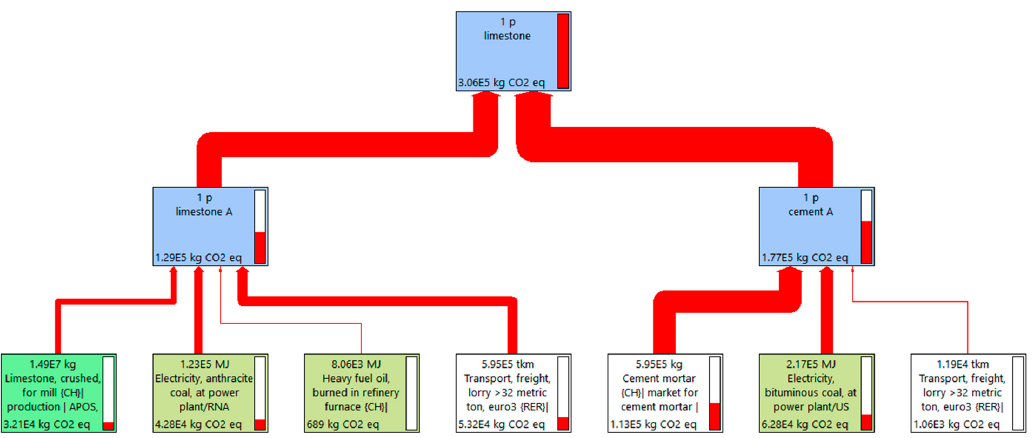
Figure 15. CO 2eq emission of 100% limestone mixture.